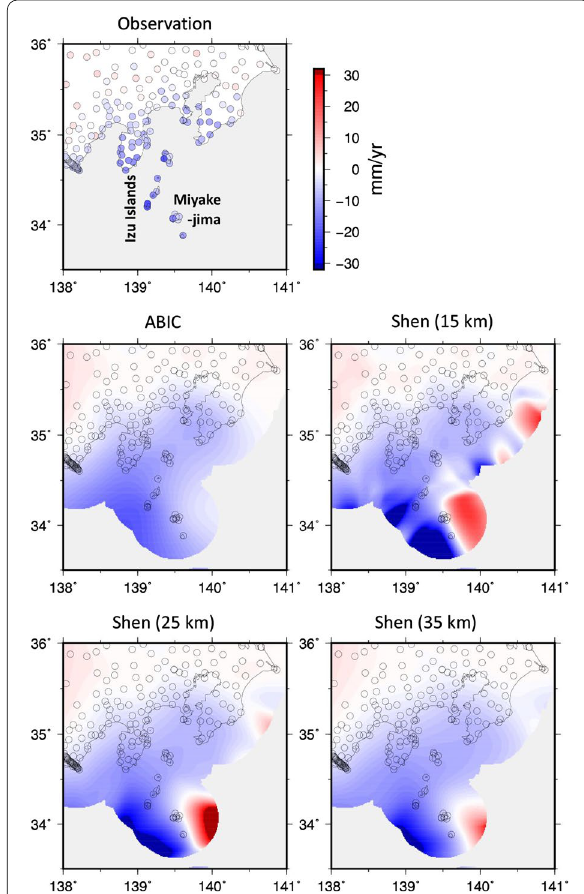
Fig. 3 Comparison of the estimated eastward velocity fields around the Izu Islands. The location is indicated by box A in Fig. 2. Results of different values of D are presented for Shen’s method. Open circles represent the GNSS stations. The top panel shows the observed velocity data